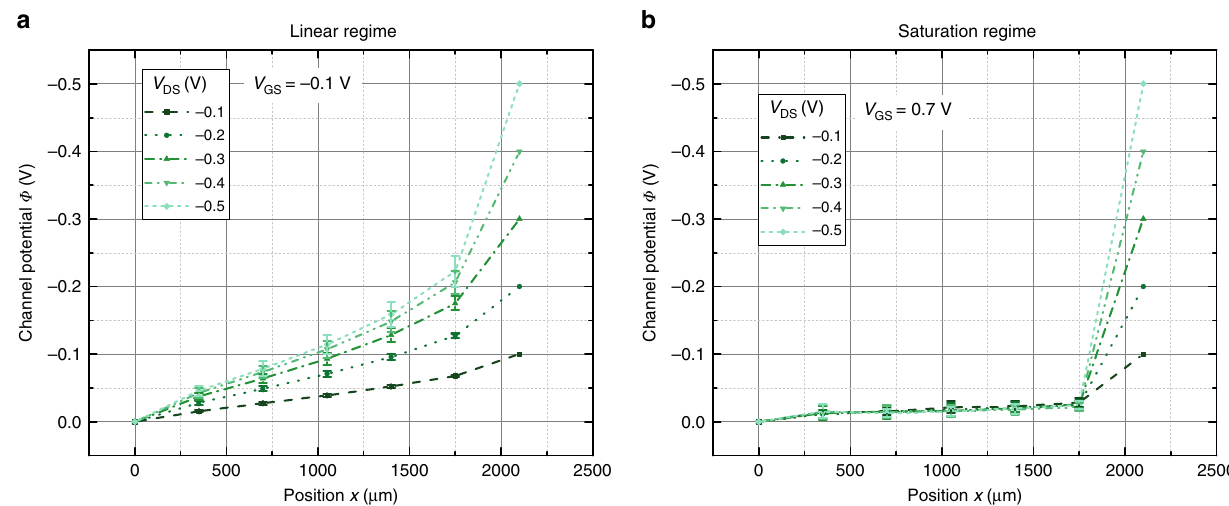
Fig. 2 Measured channel potential. a Potential along the transistor channel in the linear regime (at V GS = − 0.1 V). b Potential in the saturation regime (at V = 0.7 V). The error bars display the standard deviation of four identical GS